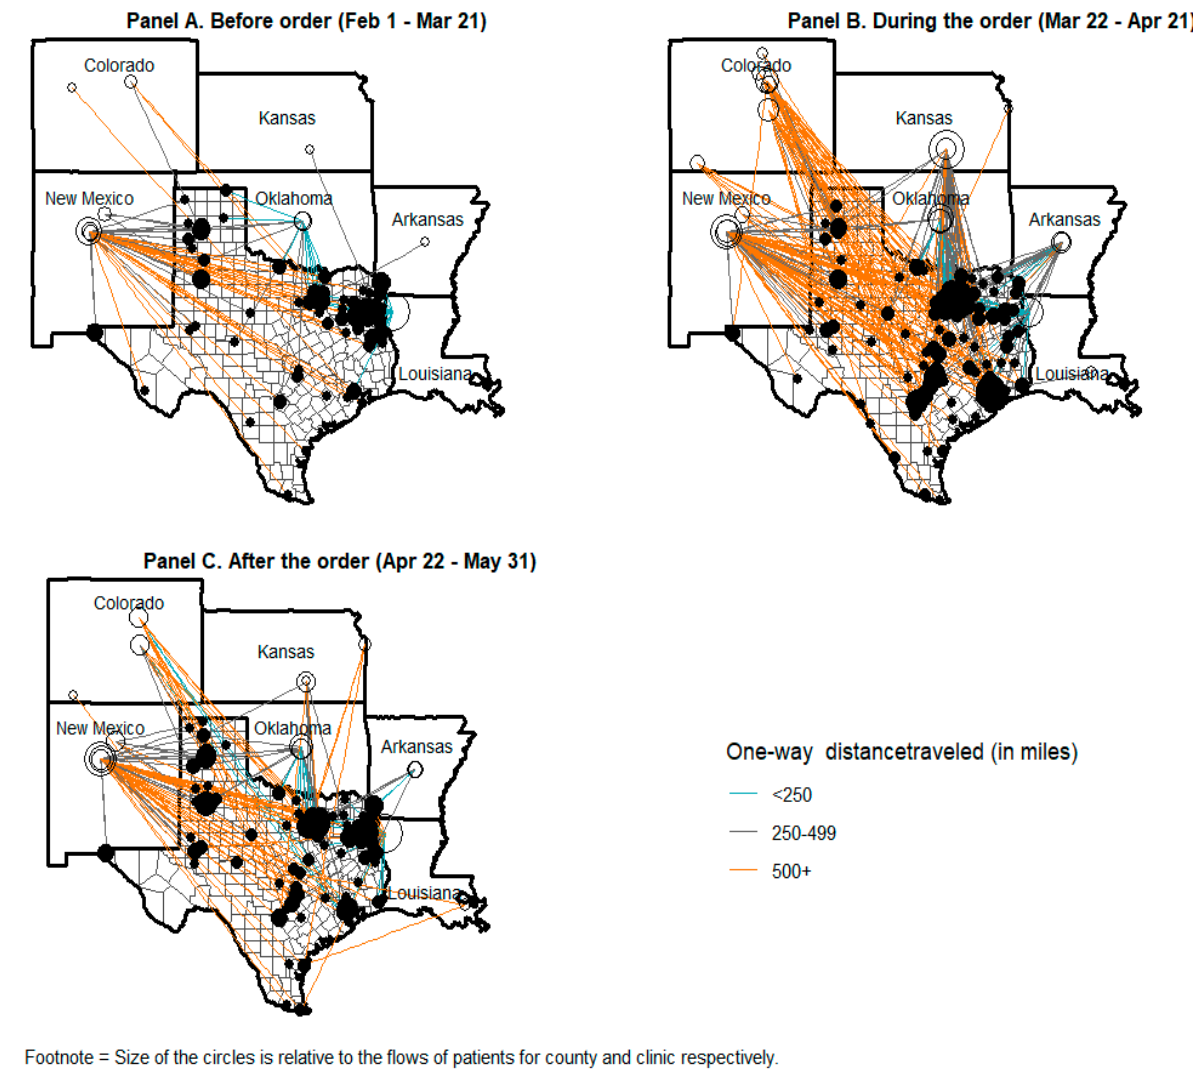
Figure 3. Flow of Texas residents obtaining out-of-state abortion care, by executive order period